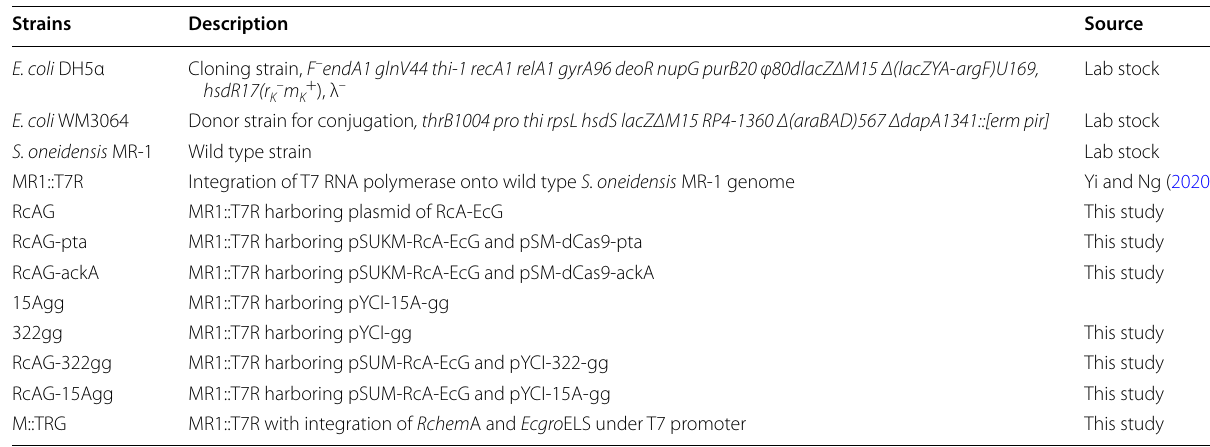
Table 1 Strains used in this study Strains